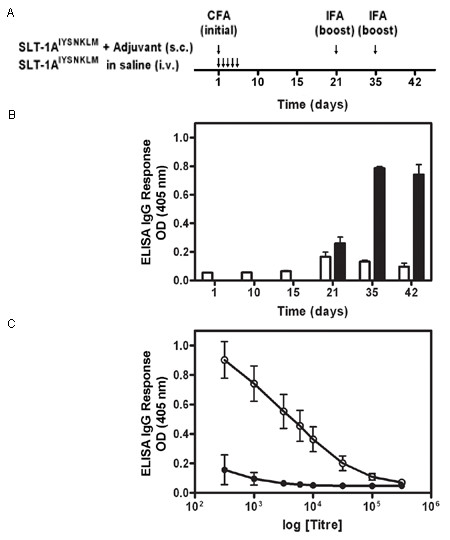
SLT-1AIYSNKLM generates modest IgG immune responses in CD1 mice. (A) Injection schedule of SLT-1AIYSNKLM with and without adjuvant. Treatments consisted of i.v. injections of SLT-1AIYSNKLM prepared in saline into CD1 mice as a series of 5 consecutive (daily) tail vein injections or a single s.c. injection of SLT-1AIYSNKLM in Complete Freund's adjuvant (CFA) followed by two s.c. boosts of the antigen in Incomplete Freund's adjuvant (IFA) at days 21 and 35. (B) Histogram illustrating the average IgG immune responses (1:1000 titer dilution) from 3 CD1 mice injected with SLT-1AIYSNKLM in the presence (black bars) or absence of adjuvant (white bars) as measured by ELISA at 405 nm. (C) Representative IgG immune responses (average ELISA signals at 405 nm versus antisera titers; day 42) engendered for groups of three CD1 mice after injection with SLT-1AIYSNKLM in the presence (white circles) or absence of adjuvant (black circles). Data represent the s.e.m. of experiments performed in triplicate.